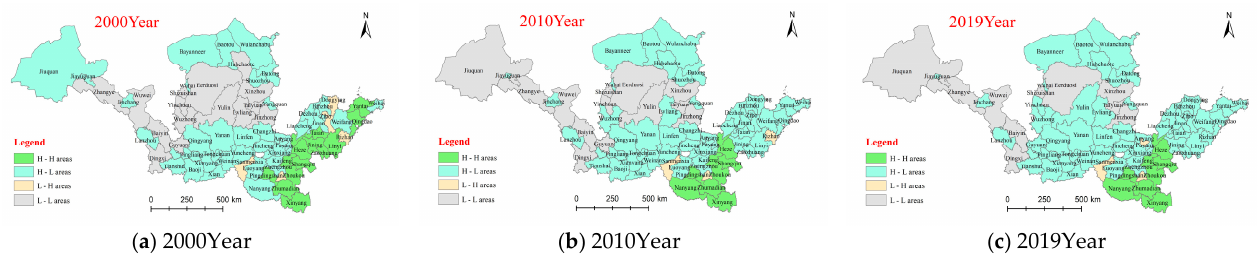
Figure 5. Moran’s index diagram of global autocorrelation of the AWF grey of prefecture-level cities in the Yellow River Basin.